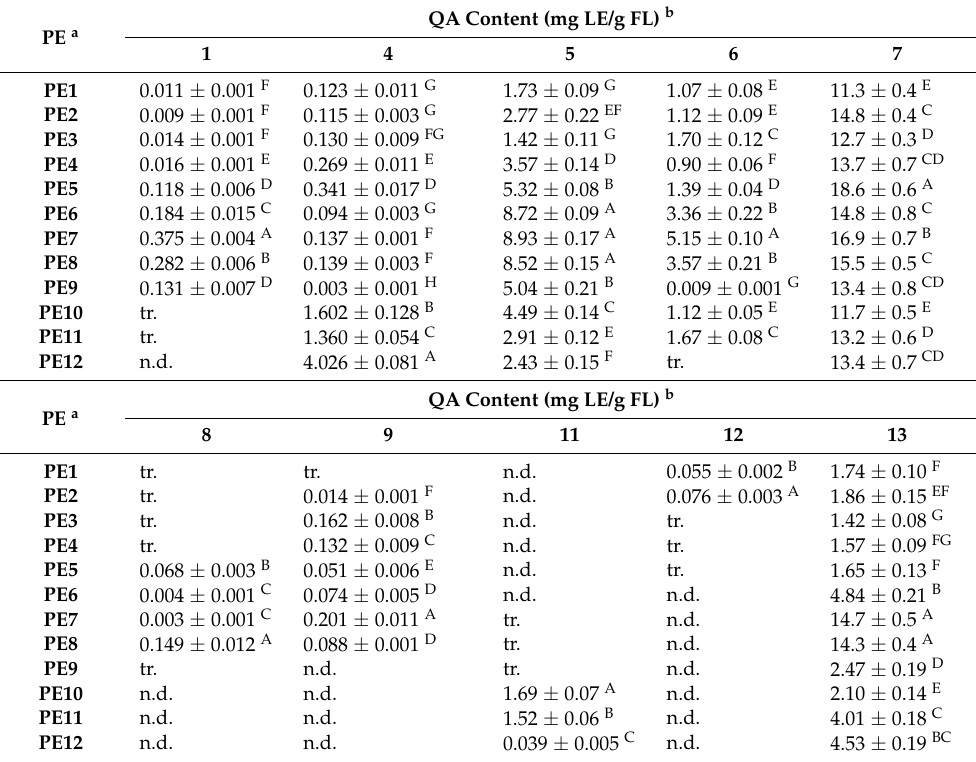
Table 3. Contents of quinolizidines detected in extracts from L. polyphyllus leaves after pruning events